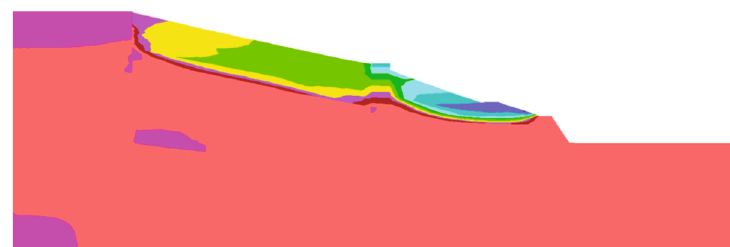
Figure 7: Lateral displacement contours.